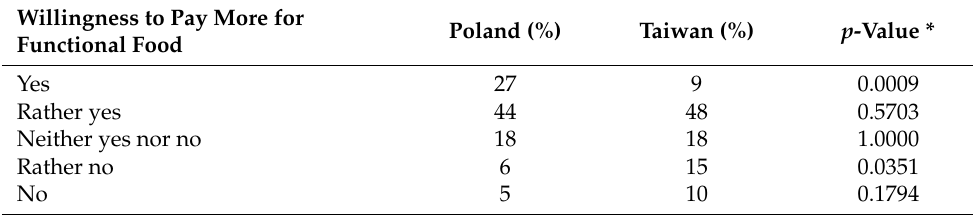
Table 6. Preparedness to pay more for functional milk